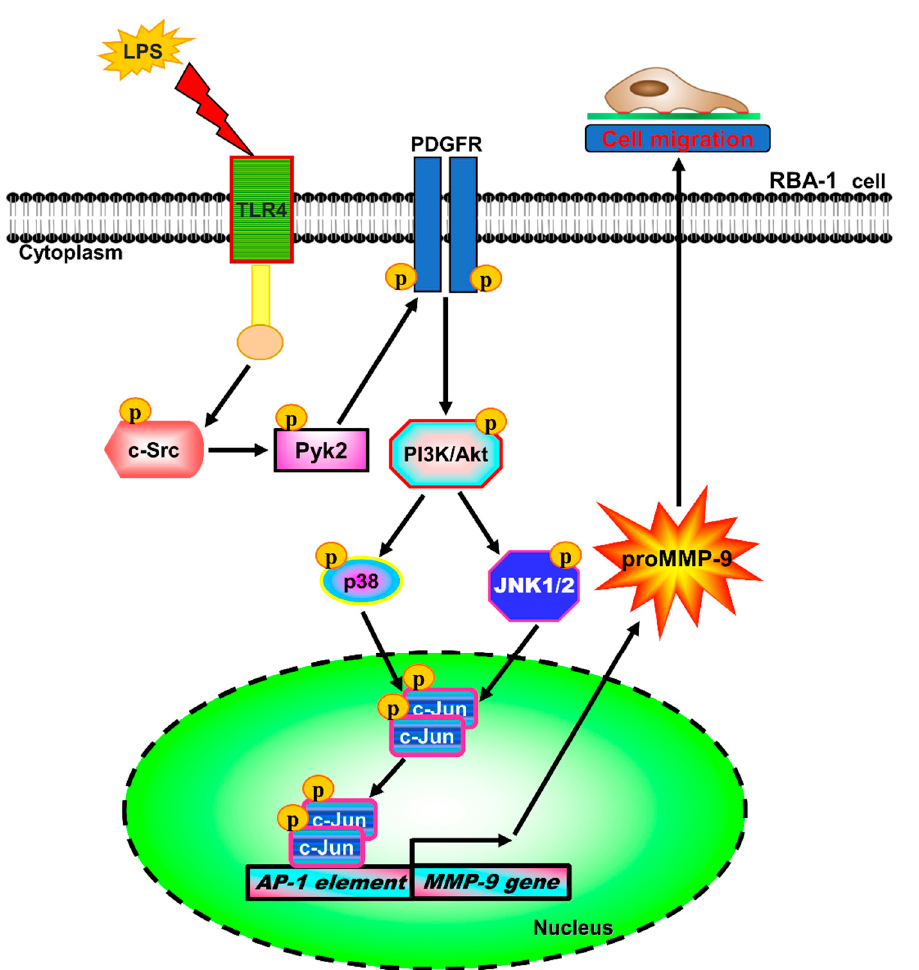
Figure 10. Schematic signaling pathways were involved in MMP-9 expression and cell migration in RBA-1 cells challenged with LPS. Our results demonstrated that LPS-induced MMP-9 expression and cell migration were mediated through a TLR4/c-Src/Pyk2/PDGFR β /PI3k/AKT/p38 MAPK and JNK1/2-dependent cascade to activate AP-1 in RBA-1 cells. : Toll/IL-1 receptor (TIR) domain